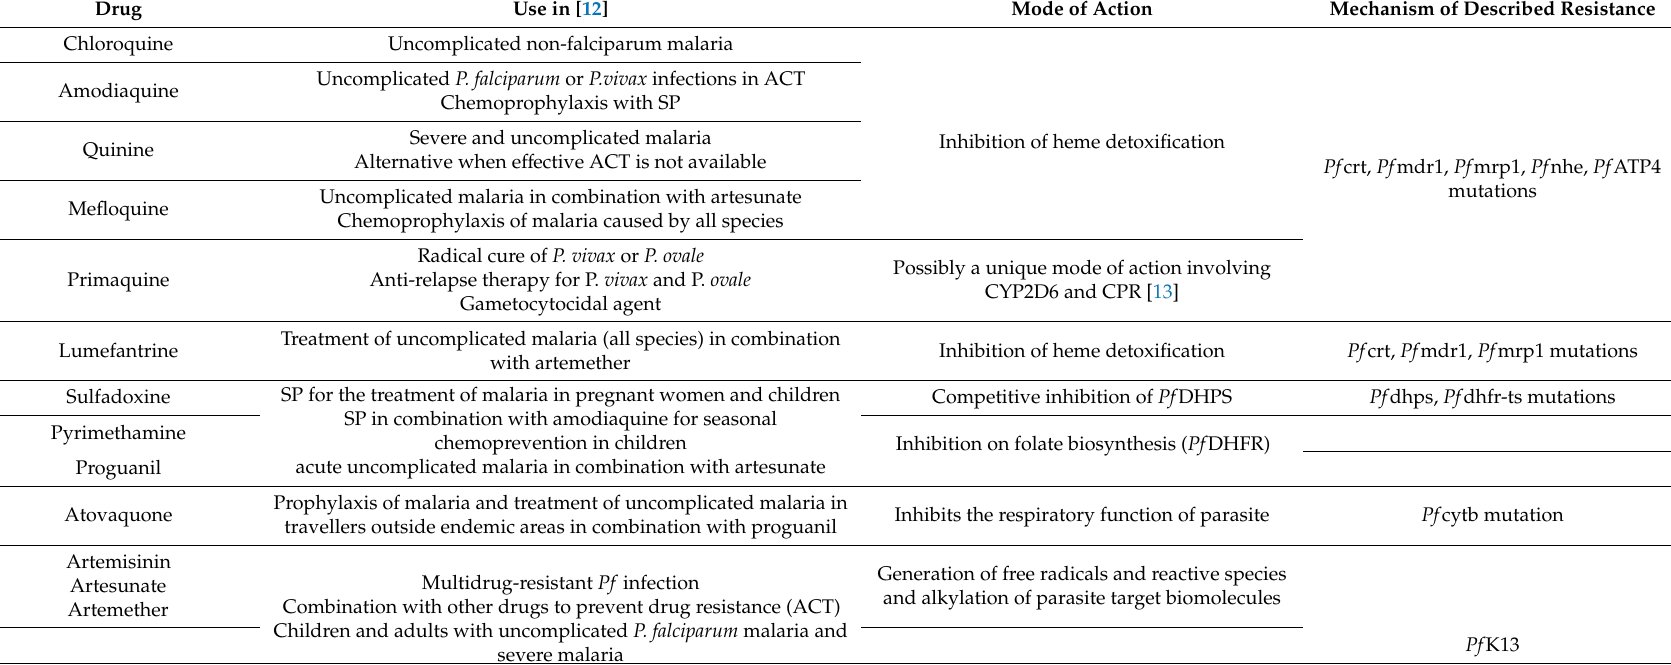
Table 1. Antimalarial drugs, their uses, and mechanisms of